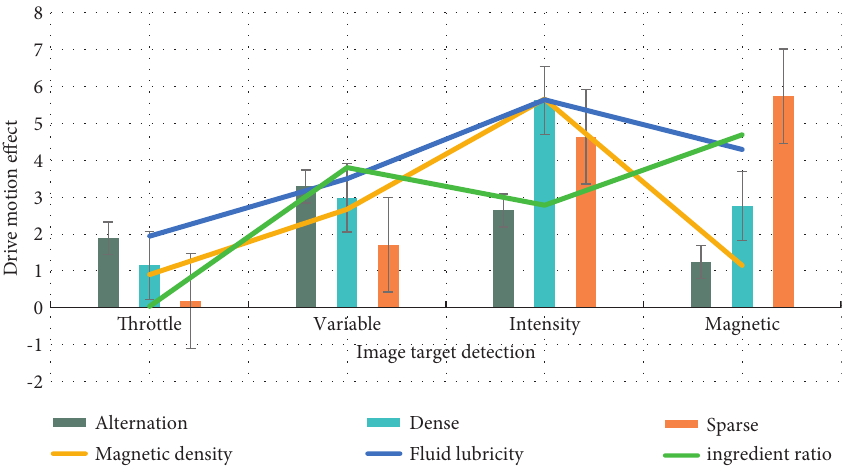
Figure 7: Volume fraction of magnetic fluid. Table 3: Lubrication performance and bearing deformation of small bearings.